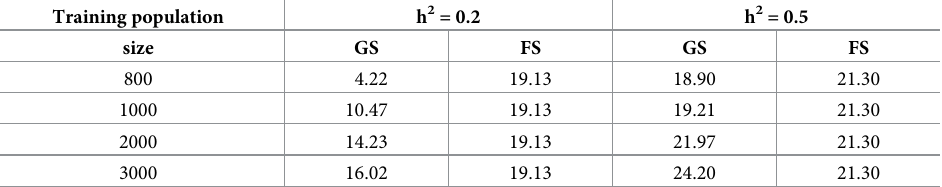
Table 5. Genetic gain per generation obtained in the prediction population from GS with 60K SNP panel for dif- ferent training population sizes (800, 1,000, 2,000 and 3,000 clones) for traits with low (h 2 = 0.2) and high (h 2 = 0.5) heritabilities in the breeding population, compared with genetic gains obtained from FS. Training population h 2 = 0.2 h 2 =